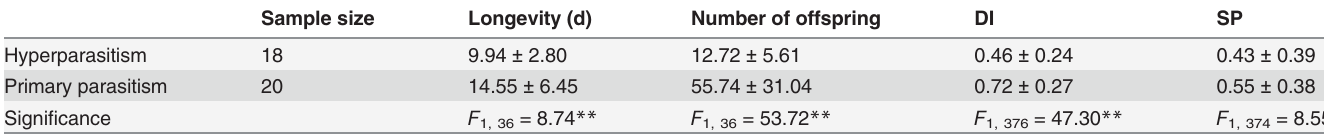
Table 3. Parameters of P . vindemmiae foundresses from the conspecific hyperparasitism and primary parasitism.